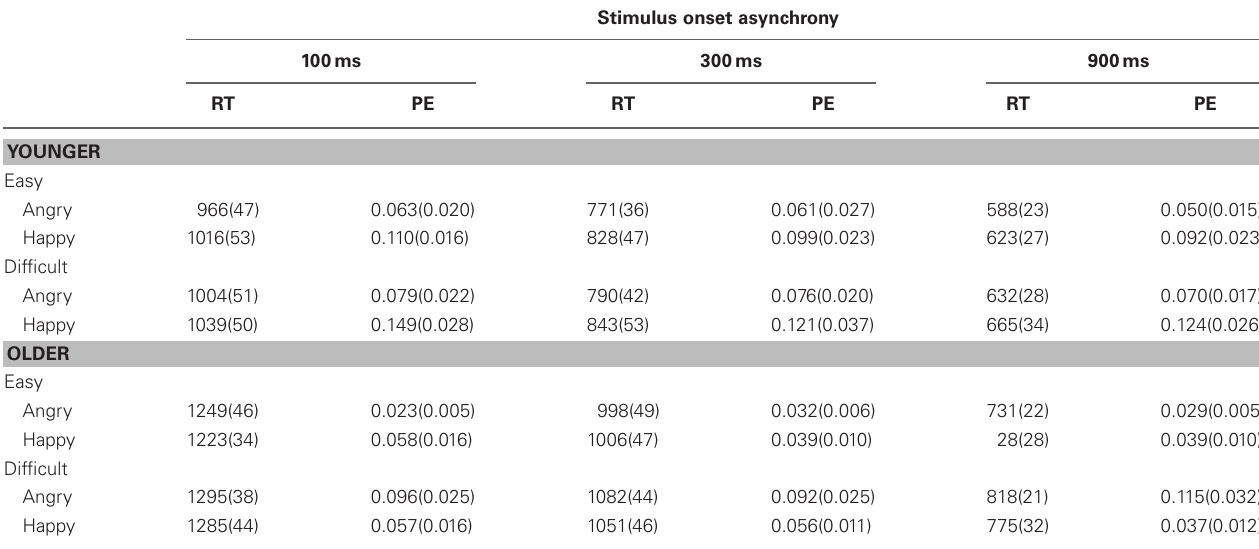
Table 2 | Mean response time (RT in ms) and proportion of errors (PE) for Task 2 as a function of age group (younger vs. older), Task-2 difficulty (easy vs. difficult), Task 2 emotion (angry vs. happy), and stimulus onset asynchrony (100, 300, and 900ms).